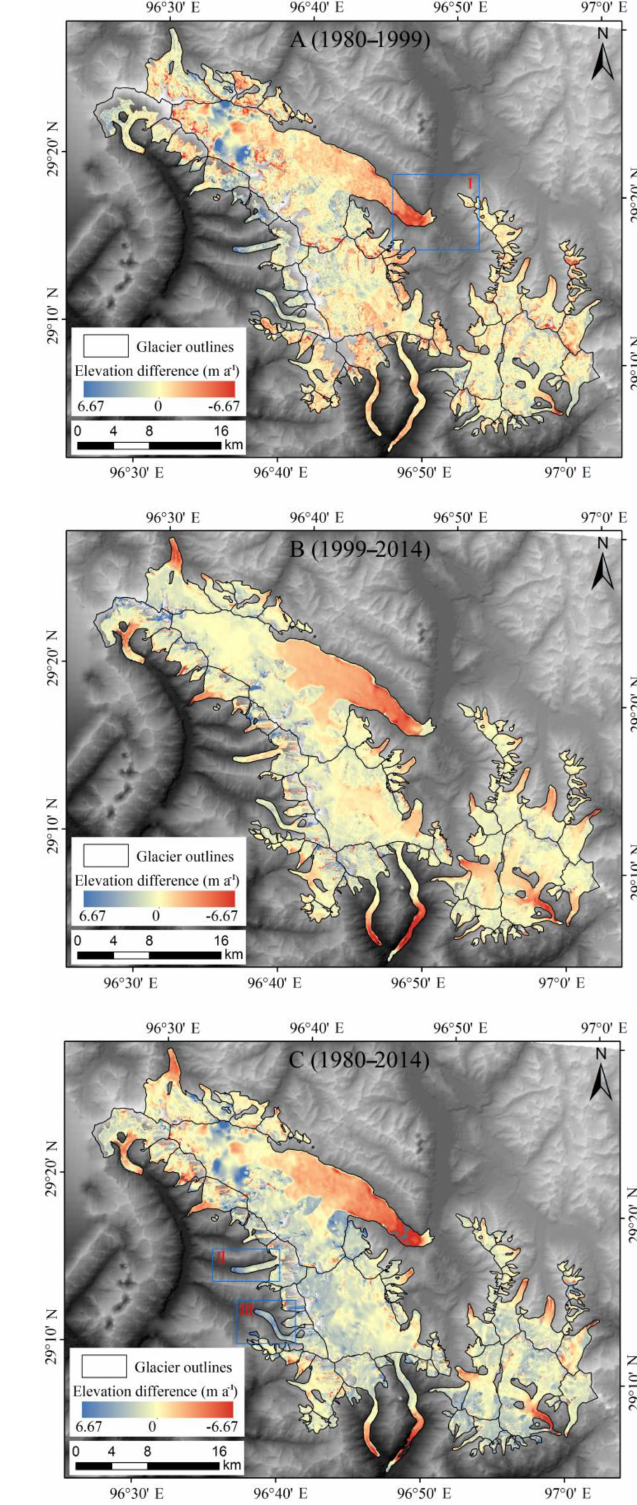
Figure 6. Elevation changes in the Kangri Karpo from 1980 to 2014. The glacier outlines are based on the geometric union of the 1980, 2000s and 2015 glacier extent. II and III are two glaciers with positive elevation changes in their